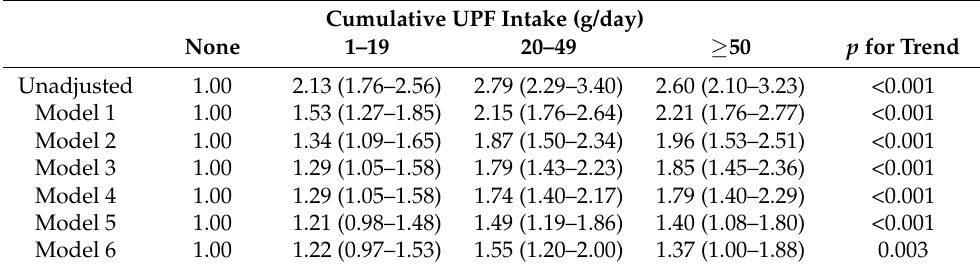
Table 2. Odds ratio (95% CI) for diabetes by cumulative ultra-processed food intake in 1997–2011 among participants attending China Health and Nutrition